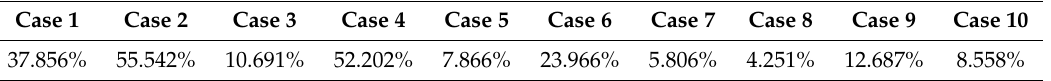
Table 8. Improvement of objective functions for GROM between scenario 1 and scenario 2.